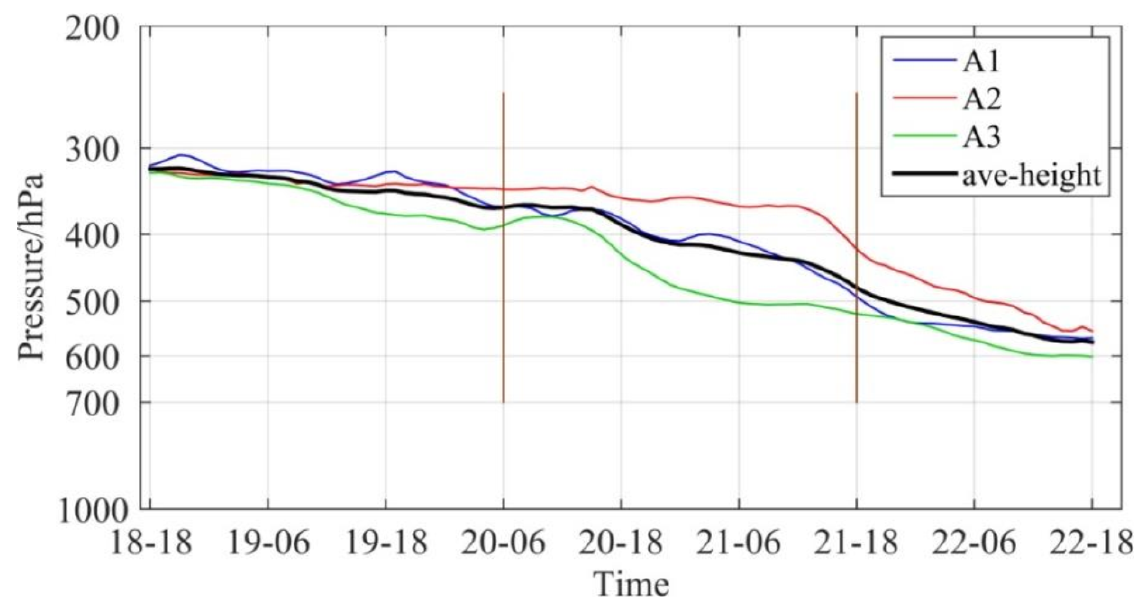
Figure 2. Time series of the average pressure of air clusters A1–A3 (blue: A1; brown: A2; green: A3) and the mean value of the average pressure of the three clusters (black). The time in horizontal axis is